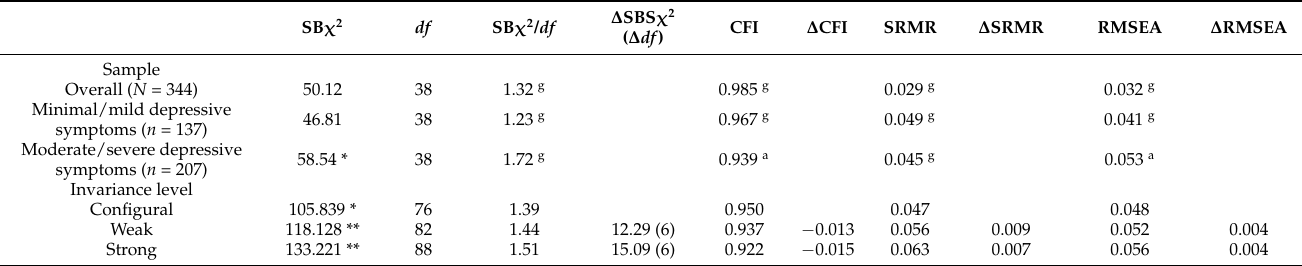
Table A5. Confirmatory factor analyses for subsamples with different severity of depressive symp- toms and invariance